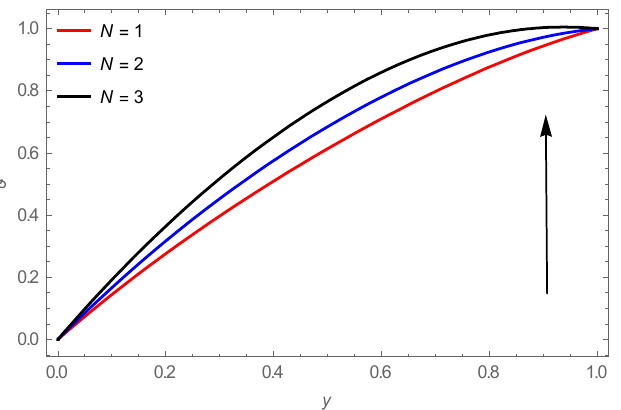
Figure 4. Impact of N on temperature field.